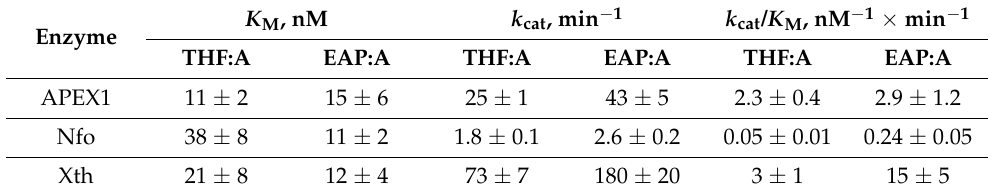
Table 2. Kinetic parameters of cleavage of THF- and EAP-containing substrates by AP endonucleases.